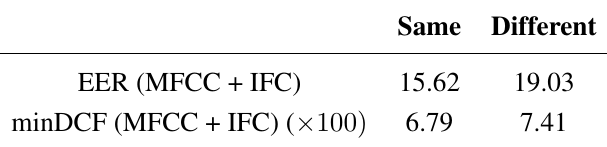
Table 2. System performance of the fused MFCC-IFC method. minDCF, minimum detection cost